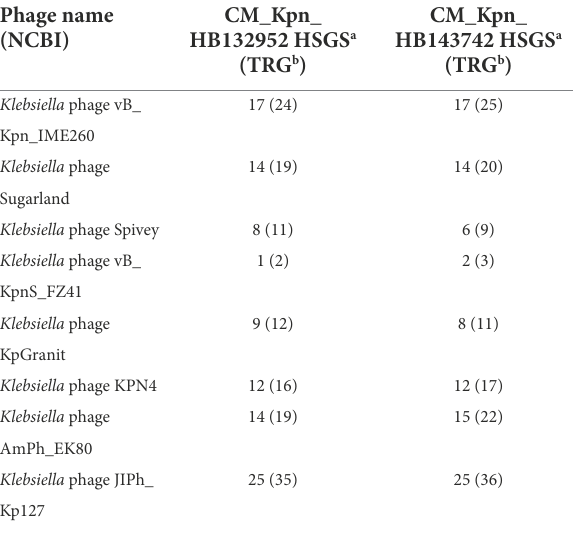
TABLE 3 Comparison of phage CM_Kpn_HB132952 and CM_Kpn_ HB143742 predicted genes with genes in the NCBI database.